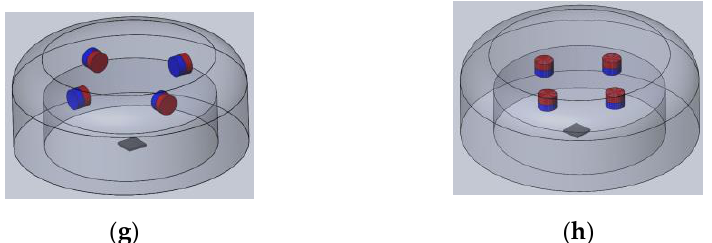
Figure 1. Several structures of soft fingertips consisting of one 3-axis Hall sensor and magnet(s):